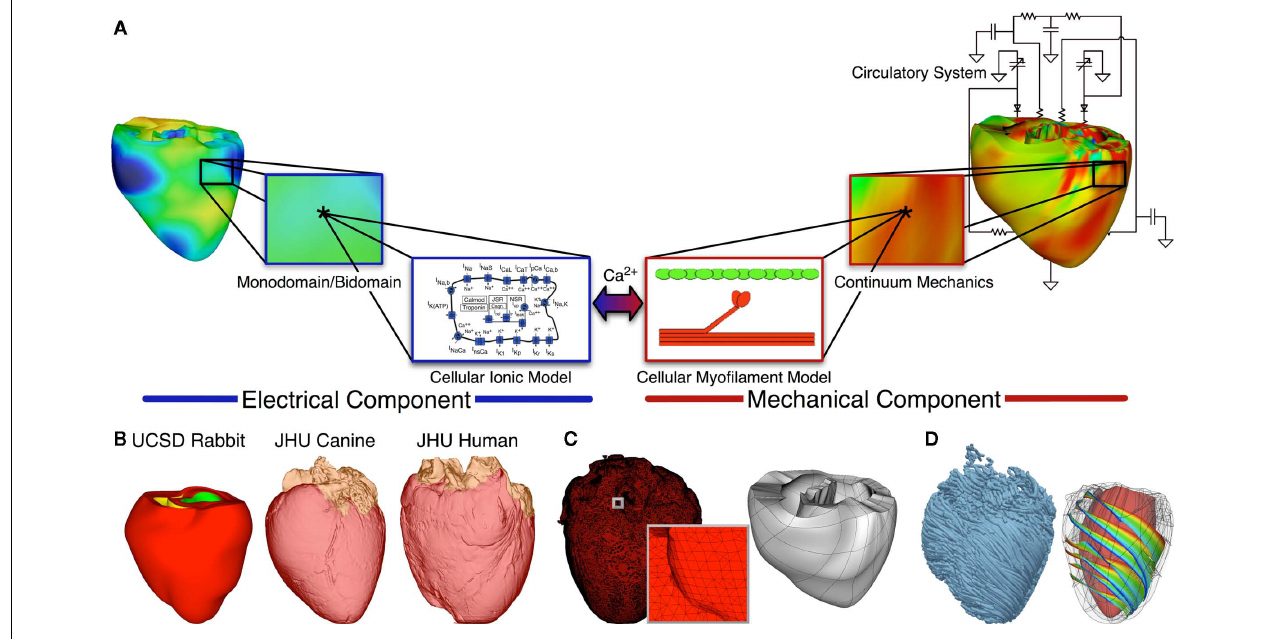
FIGURE 3 |Whole-heart modeling. (A) Schematic of the general approach to modeling cardiac EM function. (B) Geometrical models of the heart. (C) Computational meshes of the canine heart for the electrical and mechanical problems. (D) Fiber and sheet orientations obtained from DTMR imaging of the canine heart. Modified with permission fromTrayanova